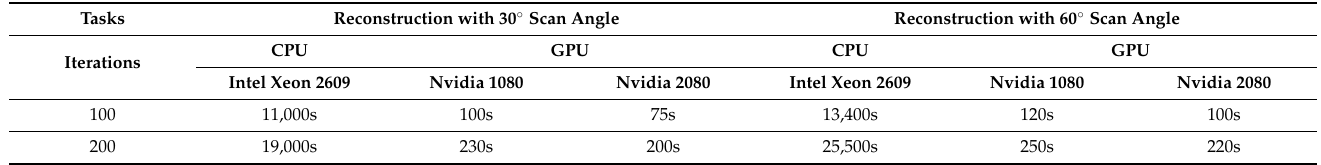
Table 3. Running time on CPU and GPU for different reconstruction tasks.